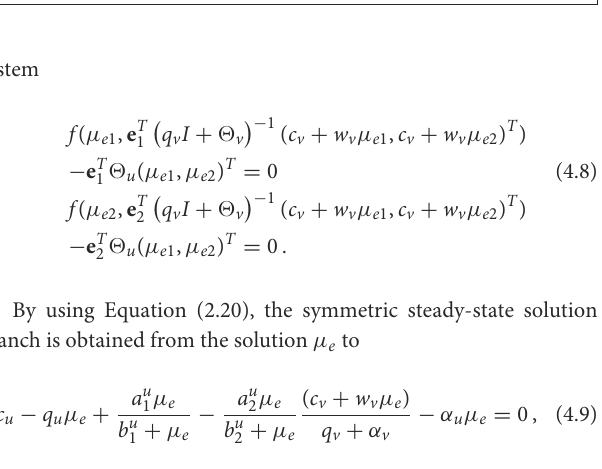
5 before the supercritical pitchfork point ρ p 9.79168, for an initial condition close to the symmetric = = (1, 1) T for ρ 15 and starting near the = − = D v 5, σ u 0.6, d u 0.09, ε 0.03, and r σ v = = = = = = =